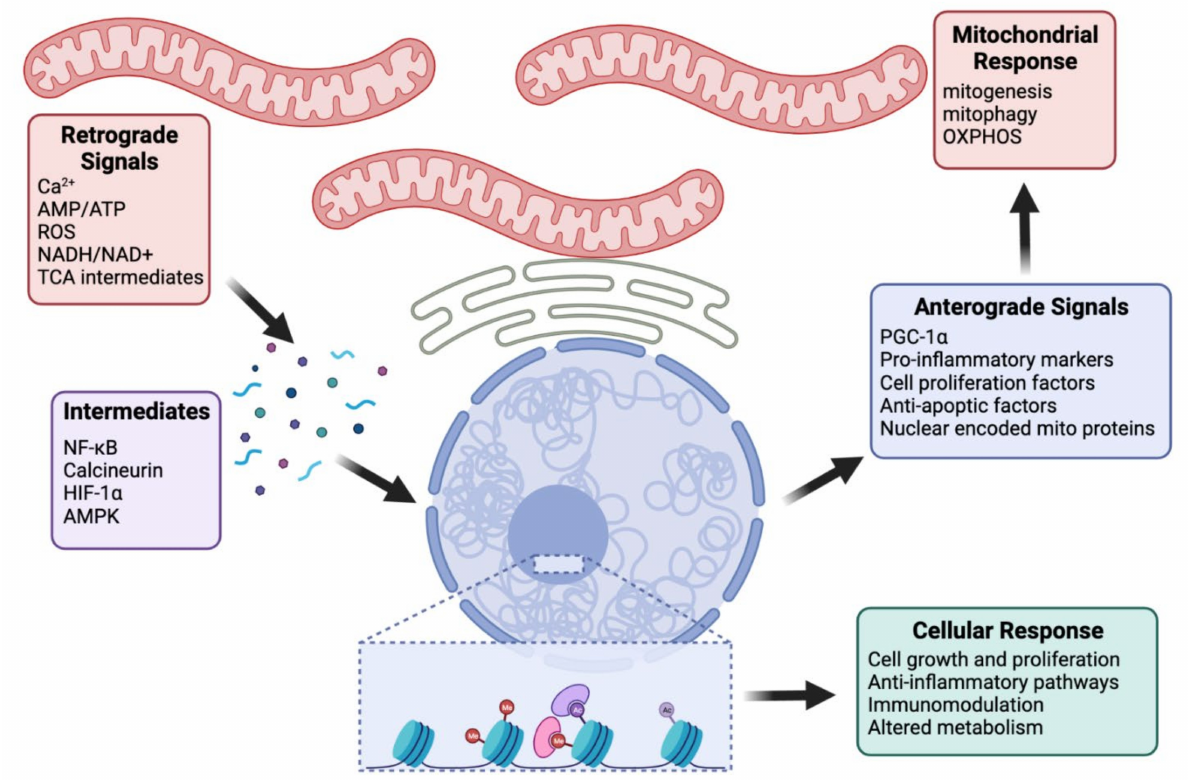
Figure 1. Signaling from the mitochondria to the nucleus. Signals originating from the mitochon- dria, including calcium, reactive oxygen species (ROS), and AMP/ATP, often stimulate pathways, leading to transcriptional changes in the nucleus. Nuclear responses can involve upregulating cell proliferation and anti-apoptotic factors, as well as proteins involved in mitogenesis, such as PGC-1 α and nuclear-encoded mitochondrial proteins. The levels of other molecules, such as TCA intermedi- ates Acetyl CoA and α -ketoglutarate, can influence the epigenome by modifying methylation and acetylation, and consequently, the cell